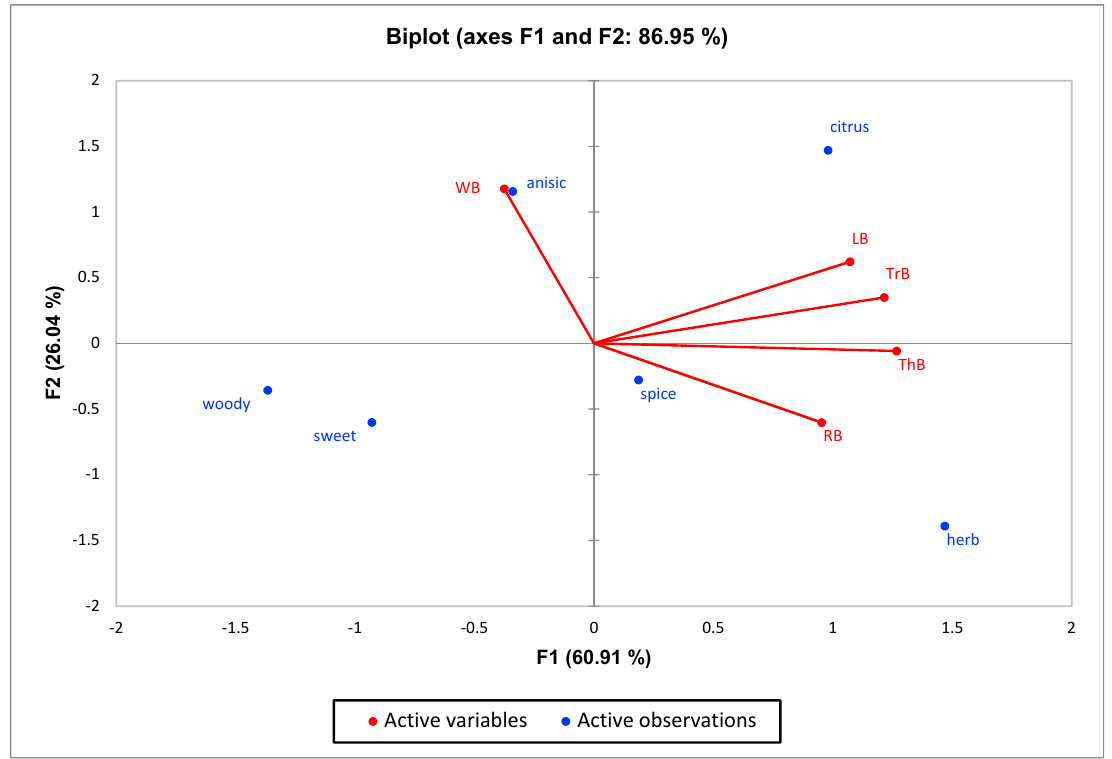
Figure 3. PCA biplot illustrating the relationships among the odour attributes and five Ocimum spp. LB = Lemon basil ( O. citriodorum ); RB = red Holy basil ( O. sanctum var. Shyama); ThB = Thai basil ( O. basilicum var. thyrsiflorum); TrB = Tree basil ( O. gratissimum ); WB = white Holy basil ( O. sanctum var. Rama).